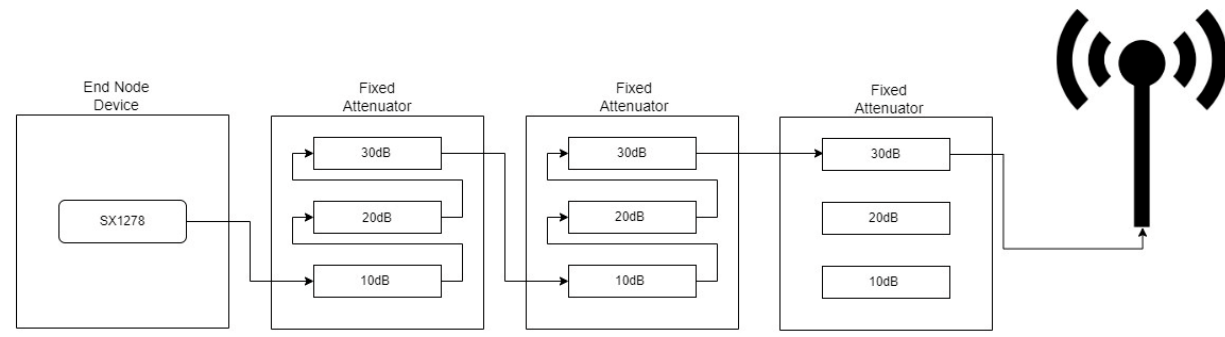
Figure 9. Block diagram of attenuators used to simulate path loss in Figure 8.